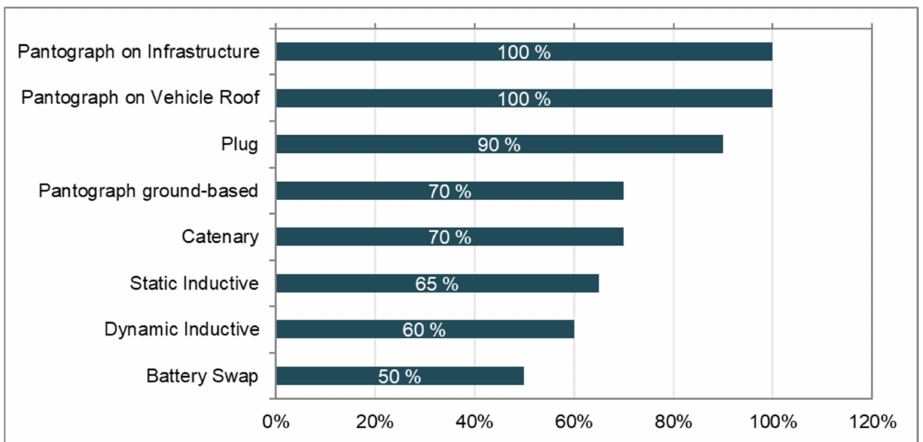
Figure 6. Familiarity of the technical respondents with charging technology types.